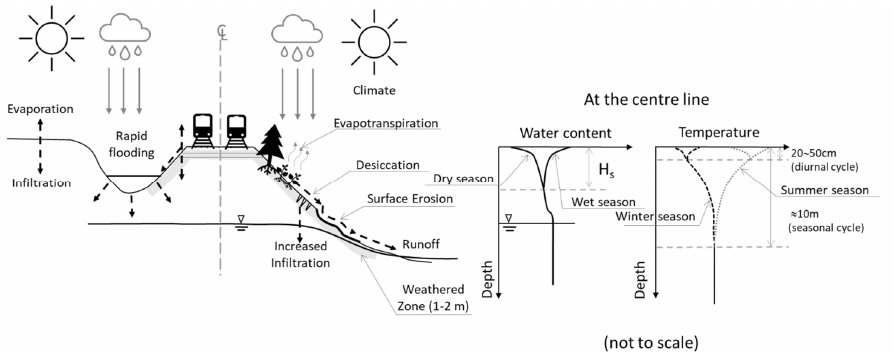
Figure 7. Cross ‐ section of a railway embankment showing the impacts relating to changing climatic patterns associated with climate change and seasonal variation of water content and temperature with depth along the centre line, modified after Heitor et al. [56] .